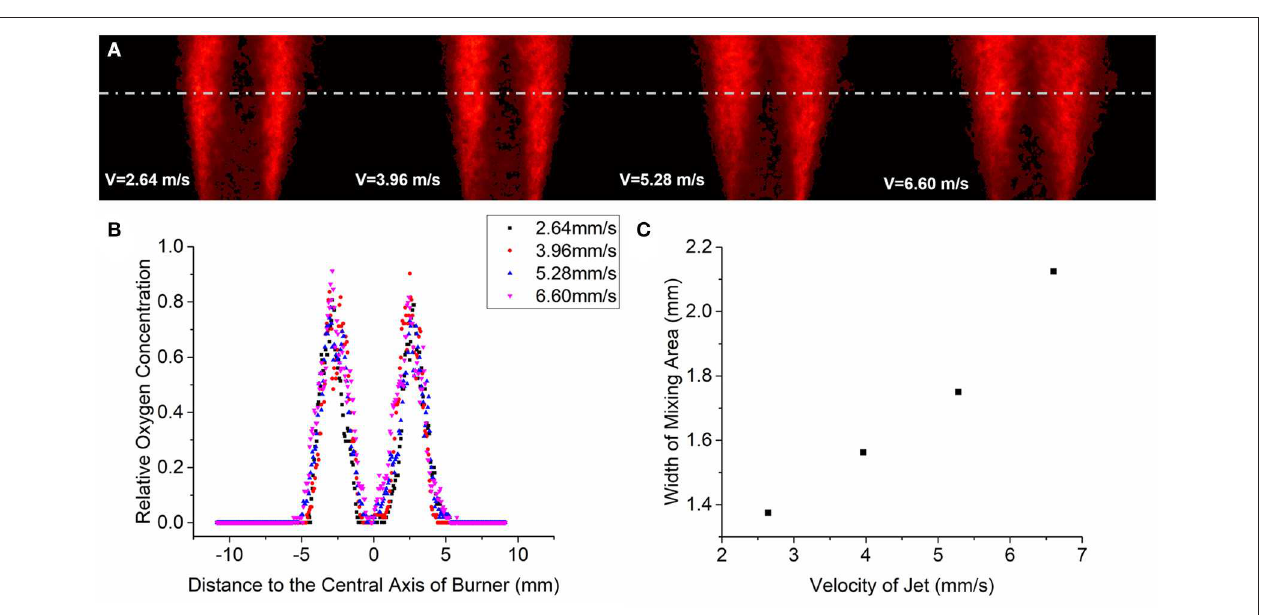
FIGURE 10 | Eighty consecutive images were selected in each working condition for average processing (A) . The cumulative average of the oxygen concentration in the horizontal direction is processed and normalized under different operation conditions (B) . The relationship between the width of the mixing region and the velocity of the jet stream (C)